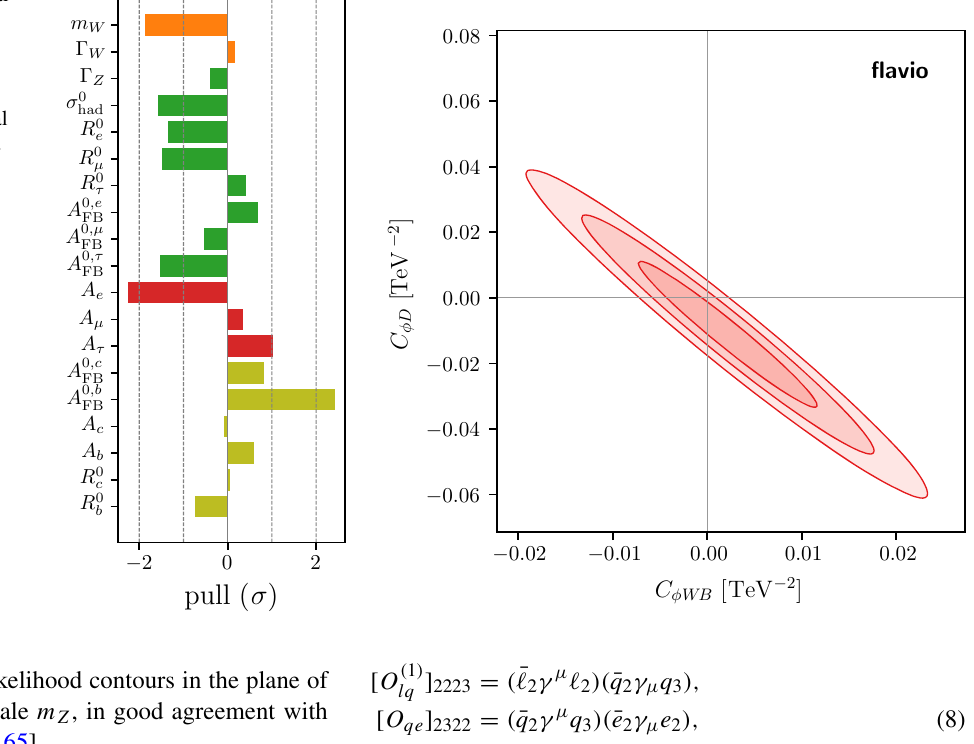
Fig. 1 Left: pulls for individual Z - and W -pole observables for the SM point. Right: 1–3 σ likelihood contours in the plane of two Warsaw-basis Wilson coefficients that are proportional to the oblique parameters S and T , assuming all other coefficients to vanish